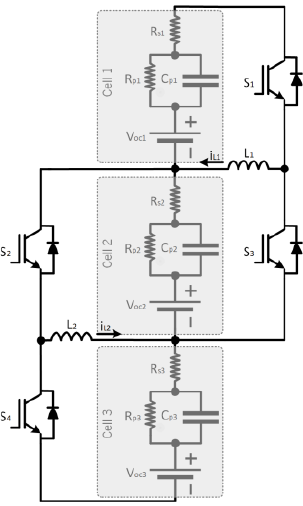
Figure 11. Switched inductor converter.